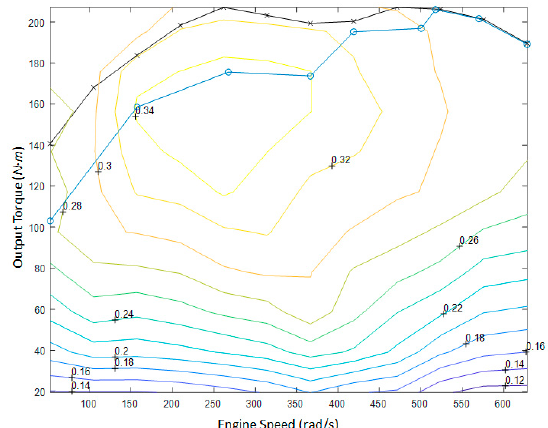
Figure 11. The speed-torque curve of the maximum output engine model (represented by points marked with an “x”), and the efficiency and optimal operating point (represented by points marked with an “o”).